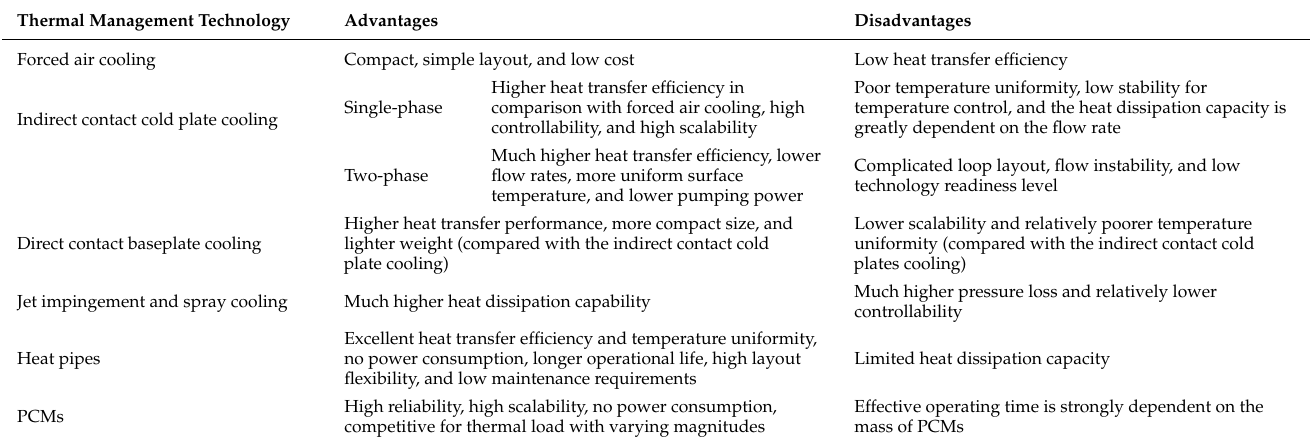
Table 8. Comparison of various thermal management technologies for electronics on board automo- biles and